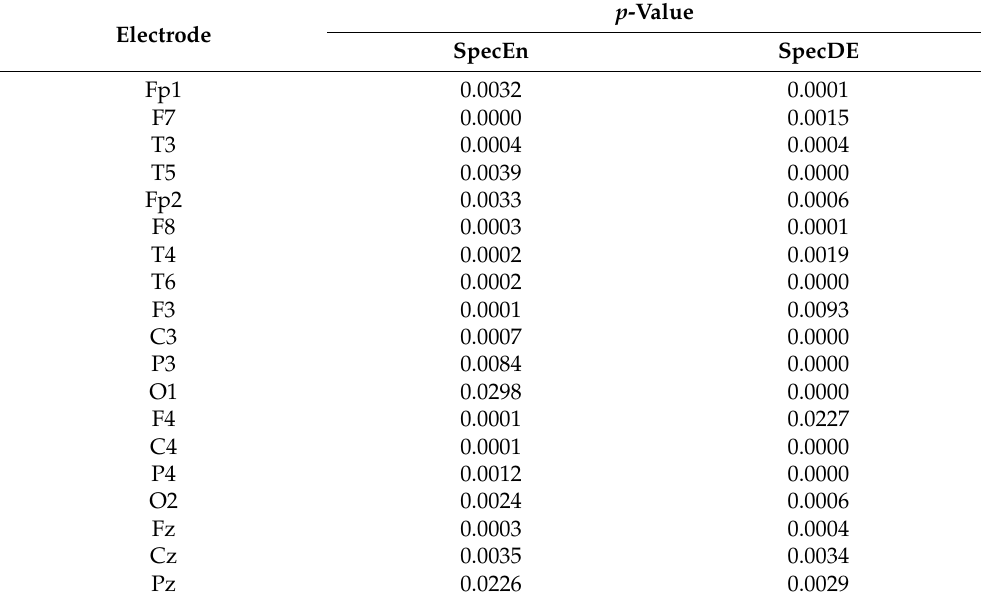
Table 8. SpecEn and SpecDE significance test results for each EEG channel.